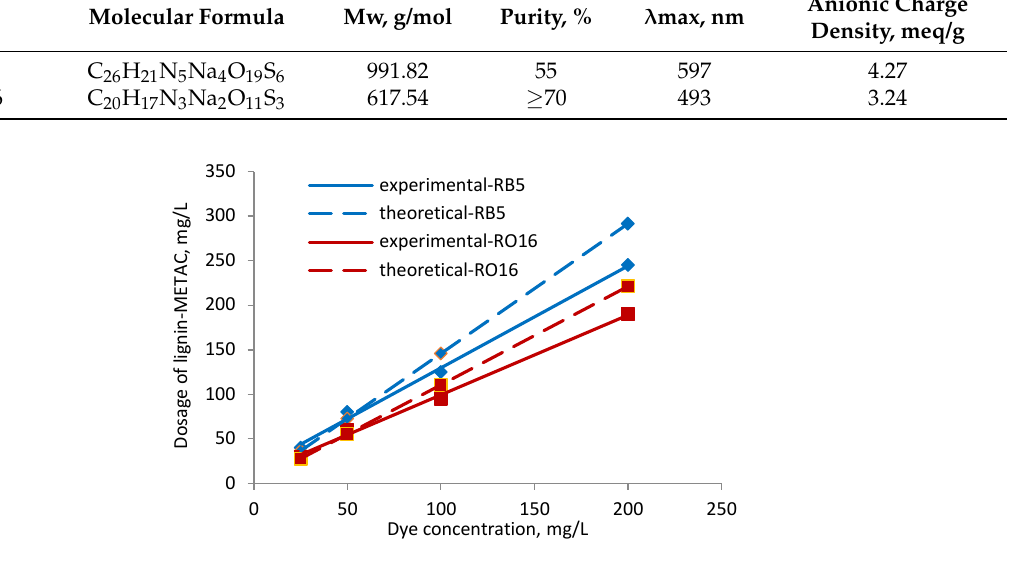
Figure 5. Relationship between optimum lignin-METAC dosage and dye concentration.